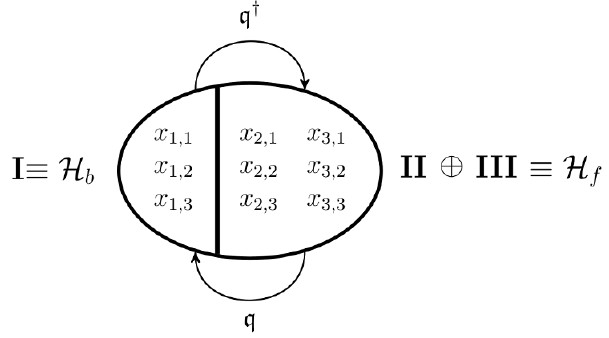
Figure 4 . The grading of the Hilbert space spanned by the partial symmetries of S 2 H f are the \bosonic" and \fermionic" parts of this grading. The grading operator is given by 1 (cid:0) 2 F = 1 (cid:0) 2( x 2 ; 2 ) which gives eigenvalue +1 on H b and -1 on H f .